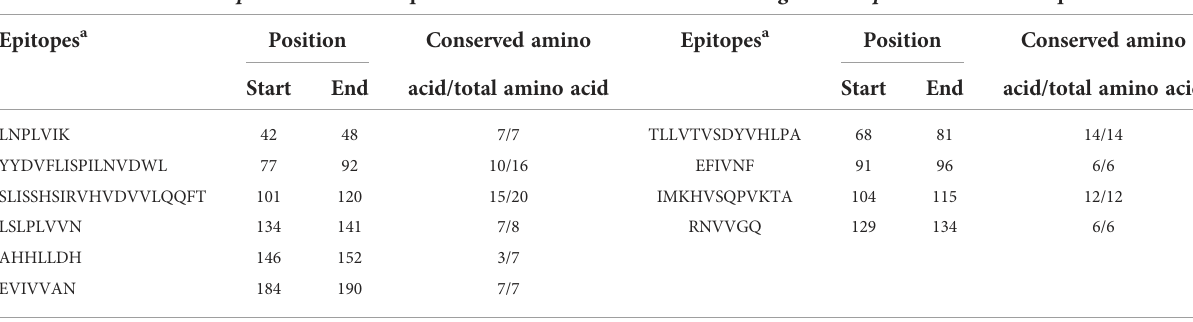
TABLE 5 Antigenicity of B-cell epitopes predicted from sbp-2 and rap-1a amino acid sequences determined in the present